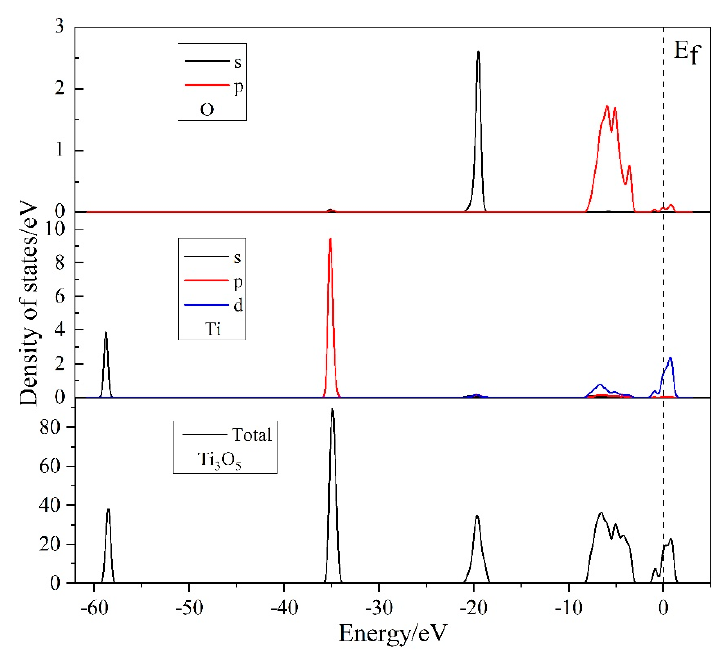
Figure 4. Total and partial density of states (DOS) of the Ti 3 O 5 crystal.